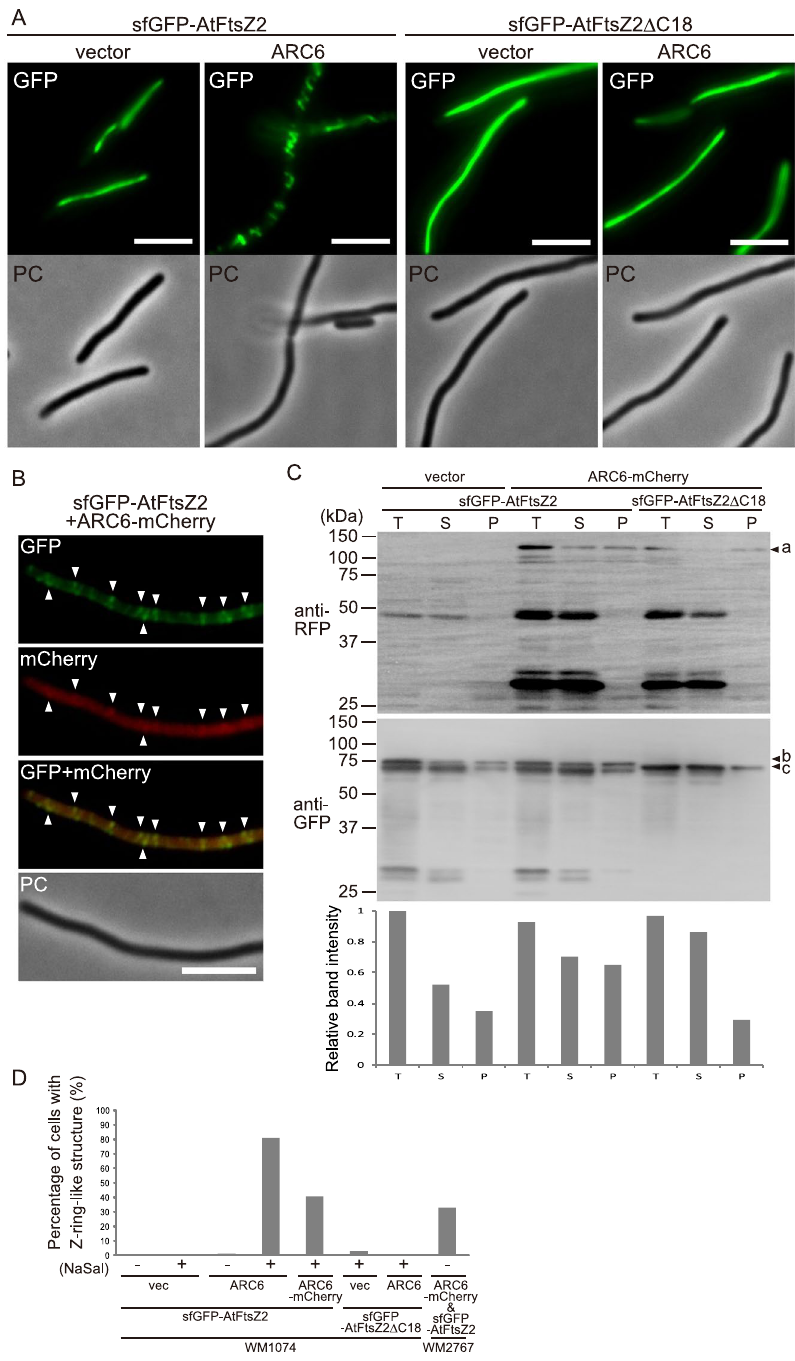
Figure 4. Chloroplast inner envelope membrane protein ARC6 accelerates FtsZ2 assembly into Z ring-like structures by interacting with the FtsZ2 C-terminus. ( A ) Effect of ARC6 expression on filament formation by AtFtsZ2 with or without the C-terminal ARC6-interacting sequence in the WM1074 strain. Scale bar: 5 µ m. ( B ) Concurrent observation of Z ring-like structures formed by sfGFP-AtFtsZ2 and ARC6-mCherry in the WM1074 strain. Arrowheads indicate overlapping signals of AtFtsZ2 Z ring-like structure and ARC6. Scale bar: 5 µ m. ( C ) Fractionation assay of the bacterial cell membrane. E. coli cells expressing sfGFP-AtFtsZ2 and ARC6-mCherry were fractionated by performing sonication and ultracentrifugation. Each protein was detected by immunoblotting with anti-GFP and anti-RFP antibodies. Arrowheads indicate the full-length protein bands of ARC6-mCherry (a), sfGFP-AtFtsZ2 (b) and sfGFP-AtFtsZ Δ C18 (c), the relative intensities of which were quantified using the software ImageJ (rsb.info.nih.gov/ij/). The band intensity of total lysate in the case of vector (pKG116) plus sfGFP-AtFtsZ2 was normalized to one. T, total lysate; S, supernatant (cytoplasmic) fraction; P, pellet (membrane) fraction. ( D ) Quantification of the Z ring-like structure signal of sfGFP-AtFtsZ2 coexpressed with ARC6 in the WM1074 and WM2767 strains. The graph shows the percentage of cells containing > 1 Z ring-like structure. The numbers of elongated bacterial cells investigated for the quantification were